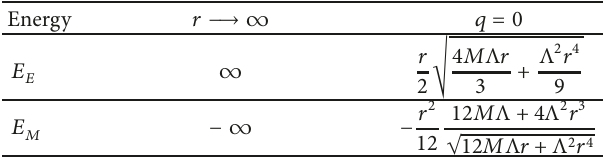
Table 1: Limiting behavior of the energy of the massive ( 𝑀 ̸= 0 ) black hole solution in the Einstein and Møller